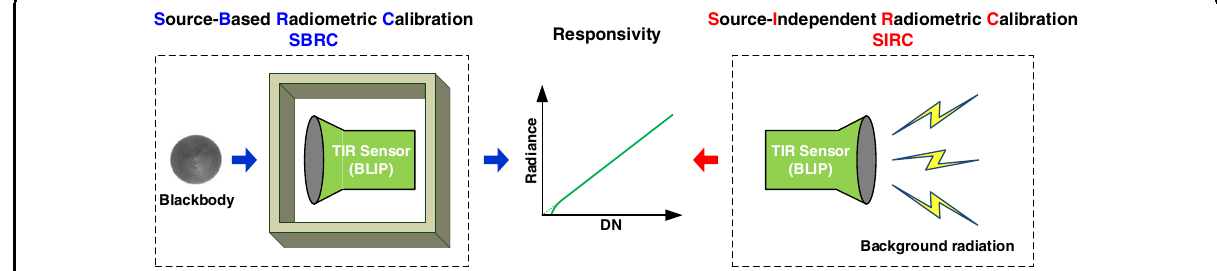
Fig. 1 Comparison of working mechanisms between SBRC and SIRC for a BLIP sensor. In SBRC, the responsivity of an IR sensor is measured as a black box to obtain its whole output when viewing the radiation from a source (i.e., blackbody). Conversely, in SIRC, the responsivity of a full or at least closely approached BLIP sensor, which can be satis fi ed by most onboard sensors, is calculated by modeling the relationship between the incident background radiation and its responsivity. In essence, SBRC is a measurement-based method while SIRC is a modeling-based one. Particularly, the responsivity here merely refers to the linear component of the whole relationship between DN and radiance illustrated